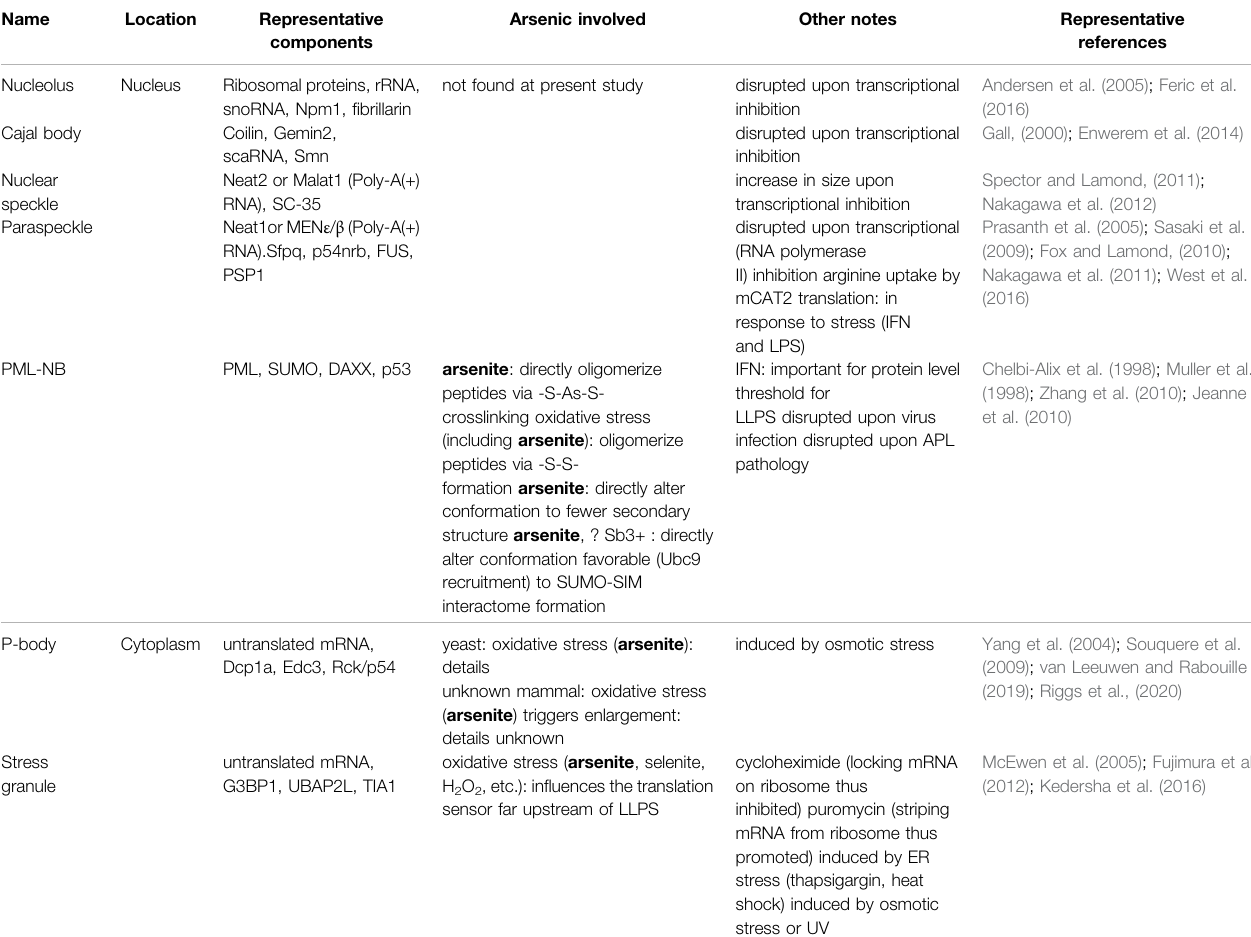
TABLE 1 | Examples of biomolecular condensates in the